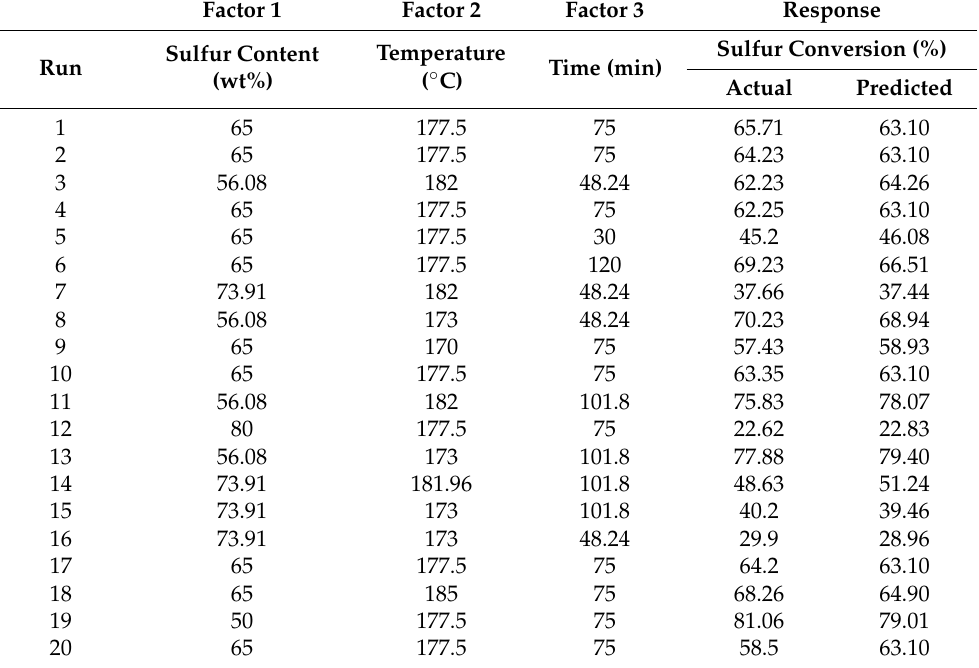
Table 2. RSM design for three independent factors using CCD for inverse vulcanization of JO with